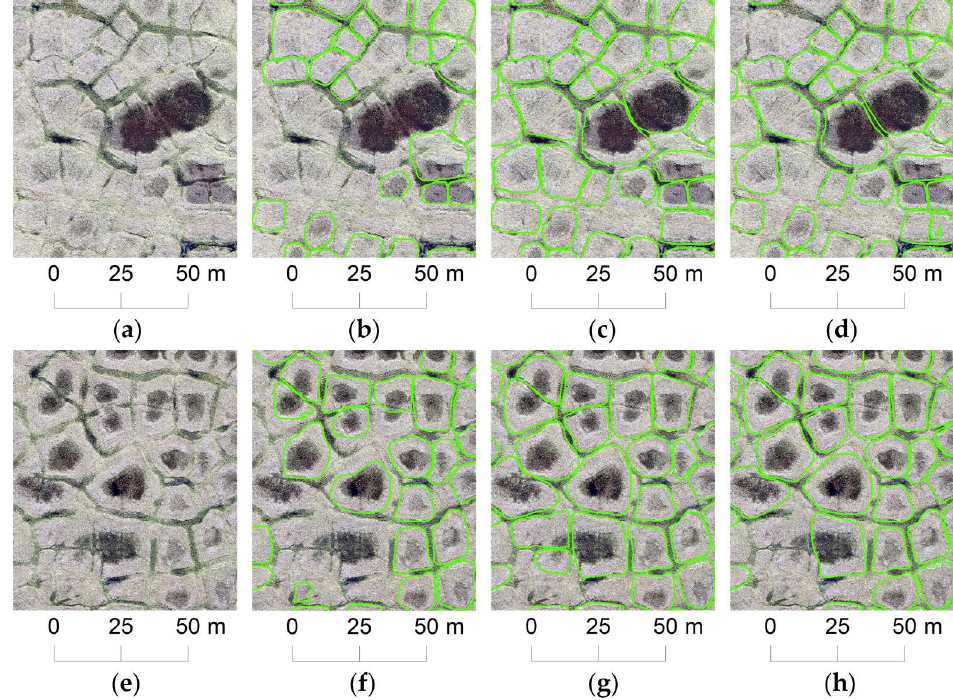
Figure 6. Examples of results of the IWP detection and delineation using the UAV image. Enlarged portions of the UAV image ( a , e ); mapped IWPs from ( a ) with green boundaries of IWPs delineated by the Mask R-CNN models used in the C4, C5, and C6 case studies ( b – d ); mapped IWPs from ( e ) with green boundaries of IWPs delineated by the Mask R-CNN models used in the C4, C5, and C6 case studies ( f – h ). Imagery © [2015] DigitalGlobe,